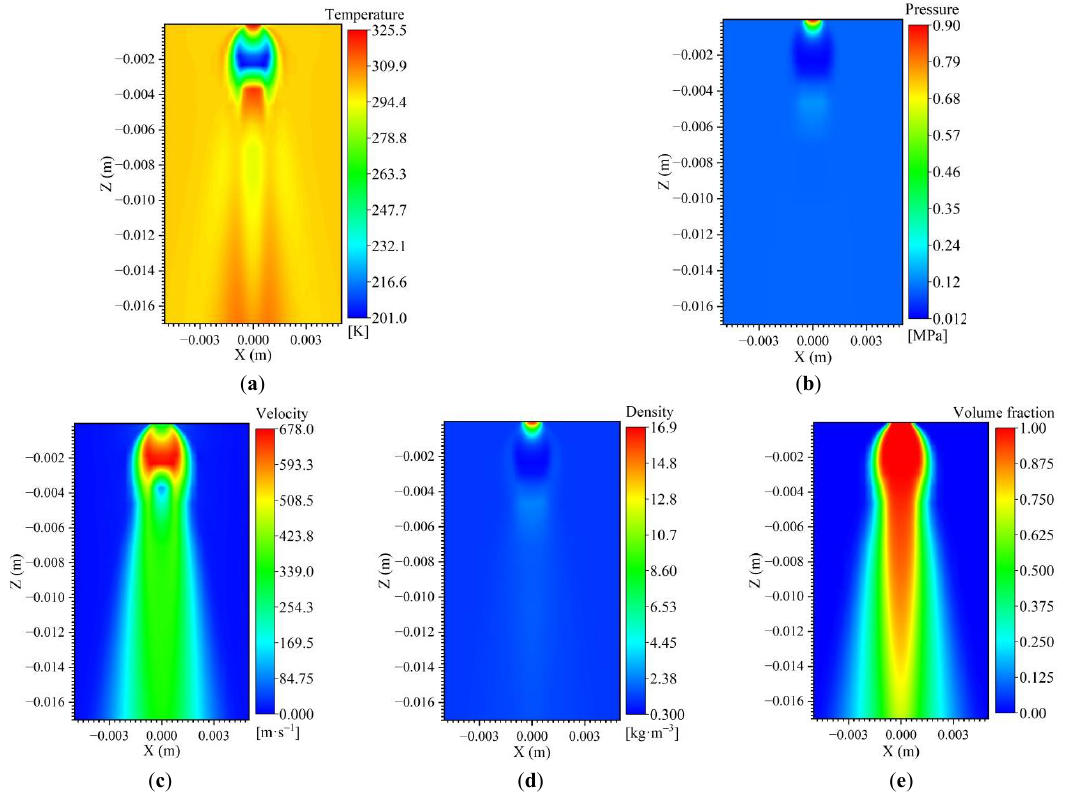
Figure 8. Cloud map of the field intensity in the local flow area below the leakage hole: ( a ) temperature cloud map; ( b ) pressure cloud map; ( c ) velocity cloud map; ( d ) density cloud map; ( e ) concentration cloud map.